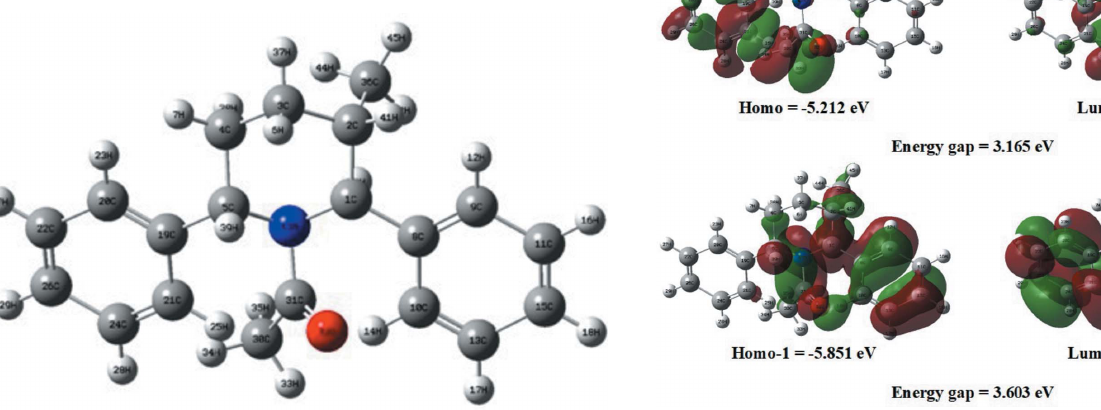
Figure 4 The optimized molecular structure of the title compound.